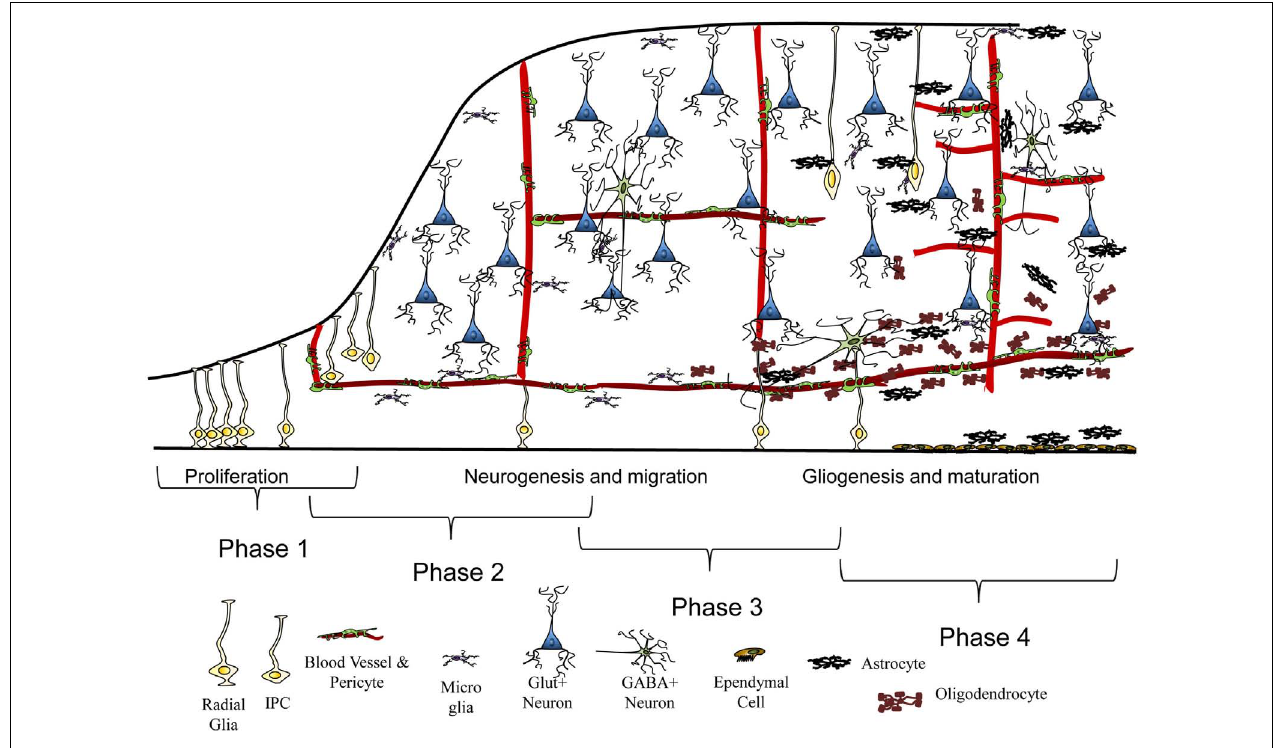
into cortical layers in an inside out manner during phase 2 and 3 of development. In phase 4 of development, gliogenesis occurs in the dorsal and ventral telencephalon. GABAergic interneurons increase their migration into the cortex.There is vascular remodeling and a maturation and integration of connections between neurons, supported by the micro and